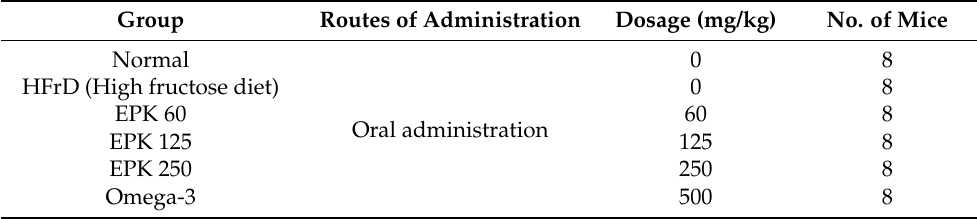
Table 1. Animal groups and